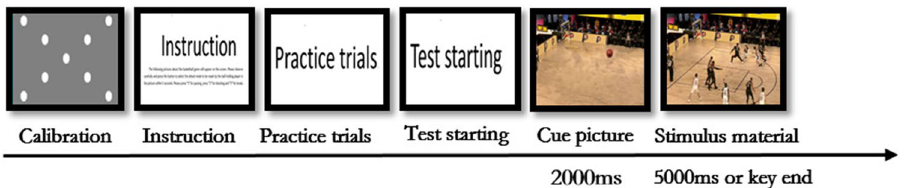
Figure 1. Illustration of the sequential phases included in a visual search